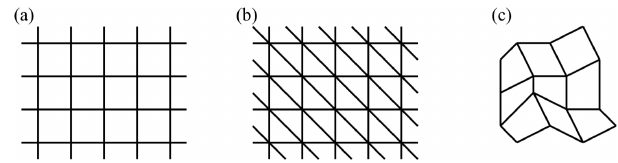
Figure 1. Eulerian grids (a, b) are reinitialized at every time step to a regular configuration. Lagrangian grids (c) evolve over time without being